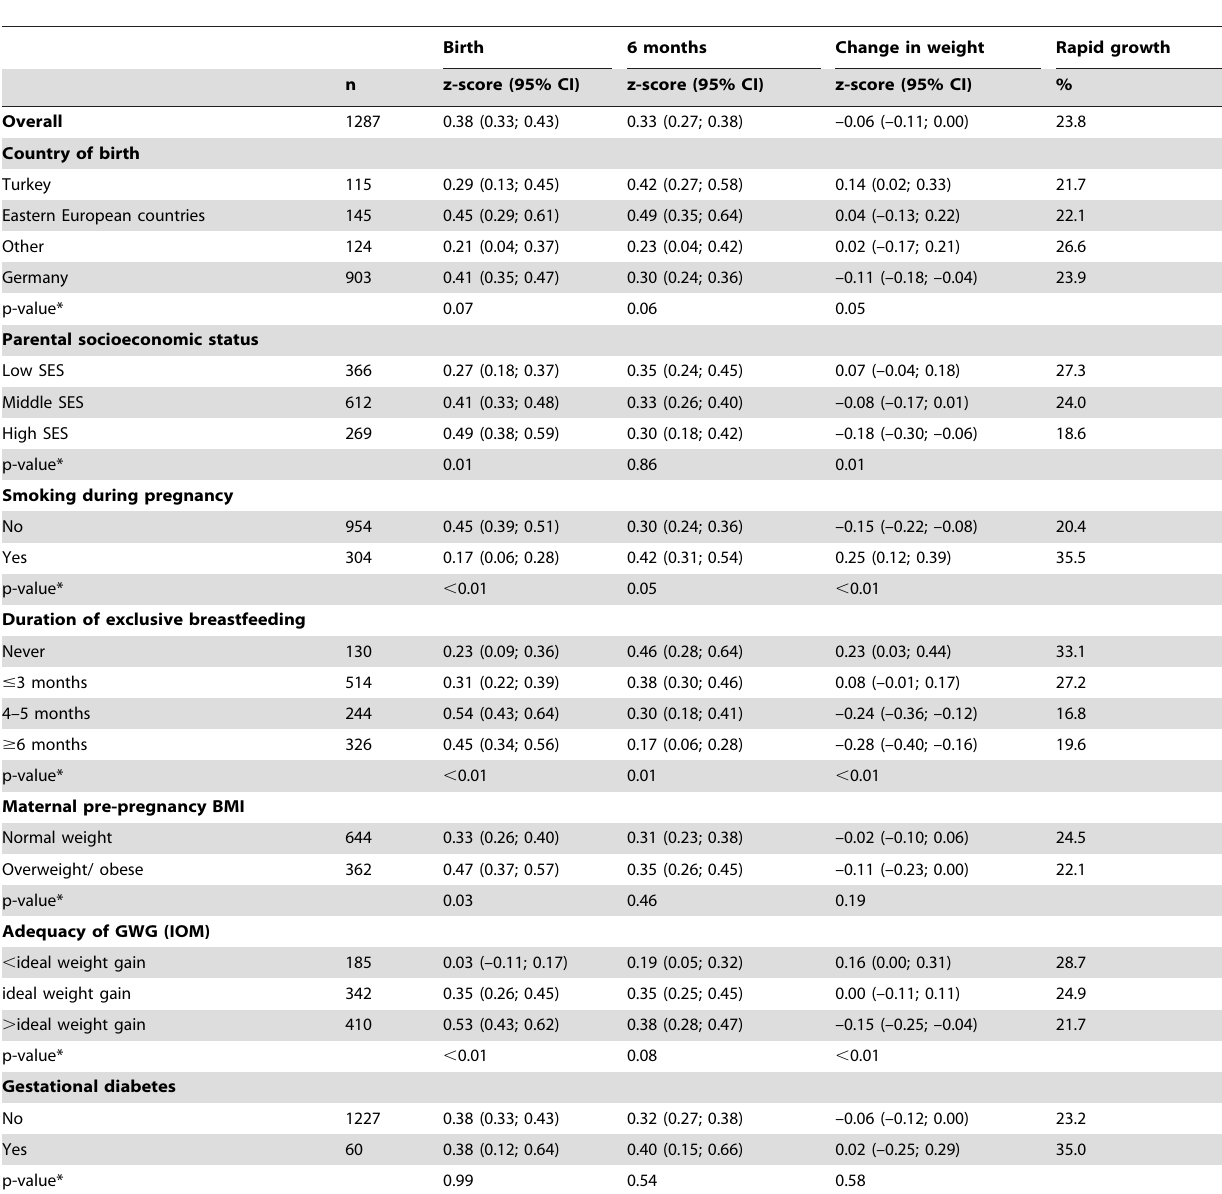
Table 2. Weight at birth, weight at six months, change in weight status during first six months (standard deviation and percent of infants with rapid growth by potentially influencing